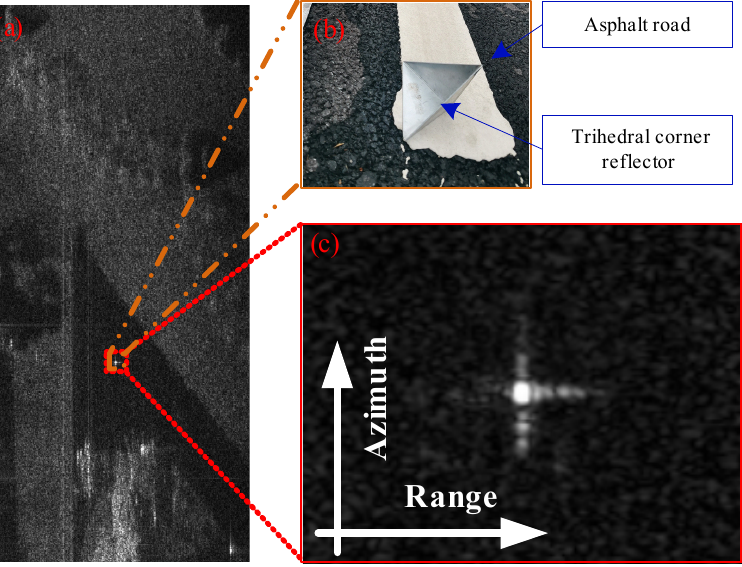
Figure 15. The SAR image with a trihedral reflector. ( a ) SAR image. ( b ) The optical image of the trihedral reflector. ( c ) The zoom-in image of the trihedral reflector.